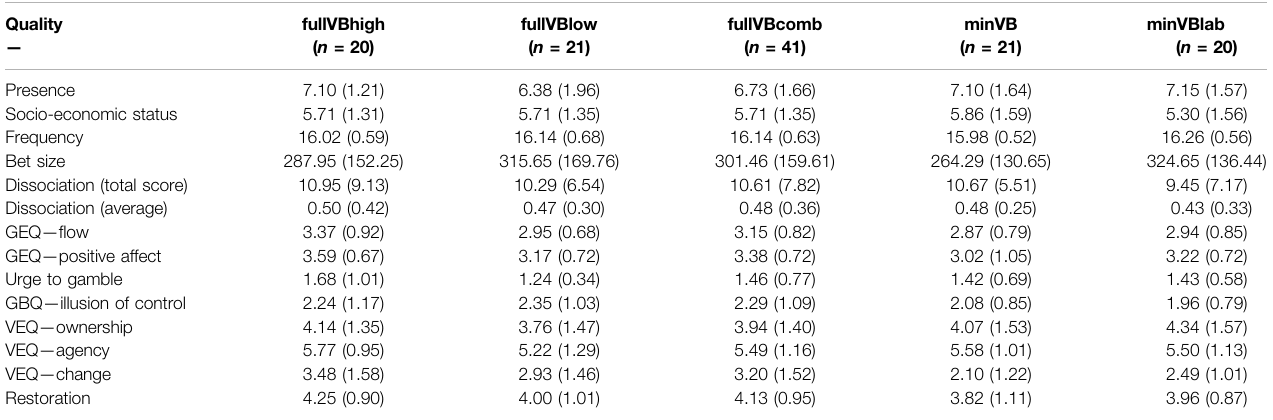
TABLE 5 | Overview of the mean scores per condition. Values are M (SD). Quality fullVBhigh